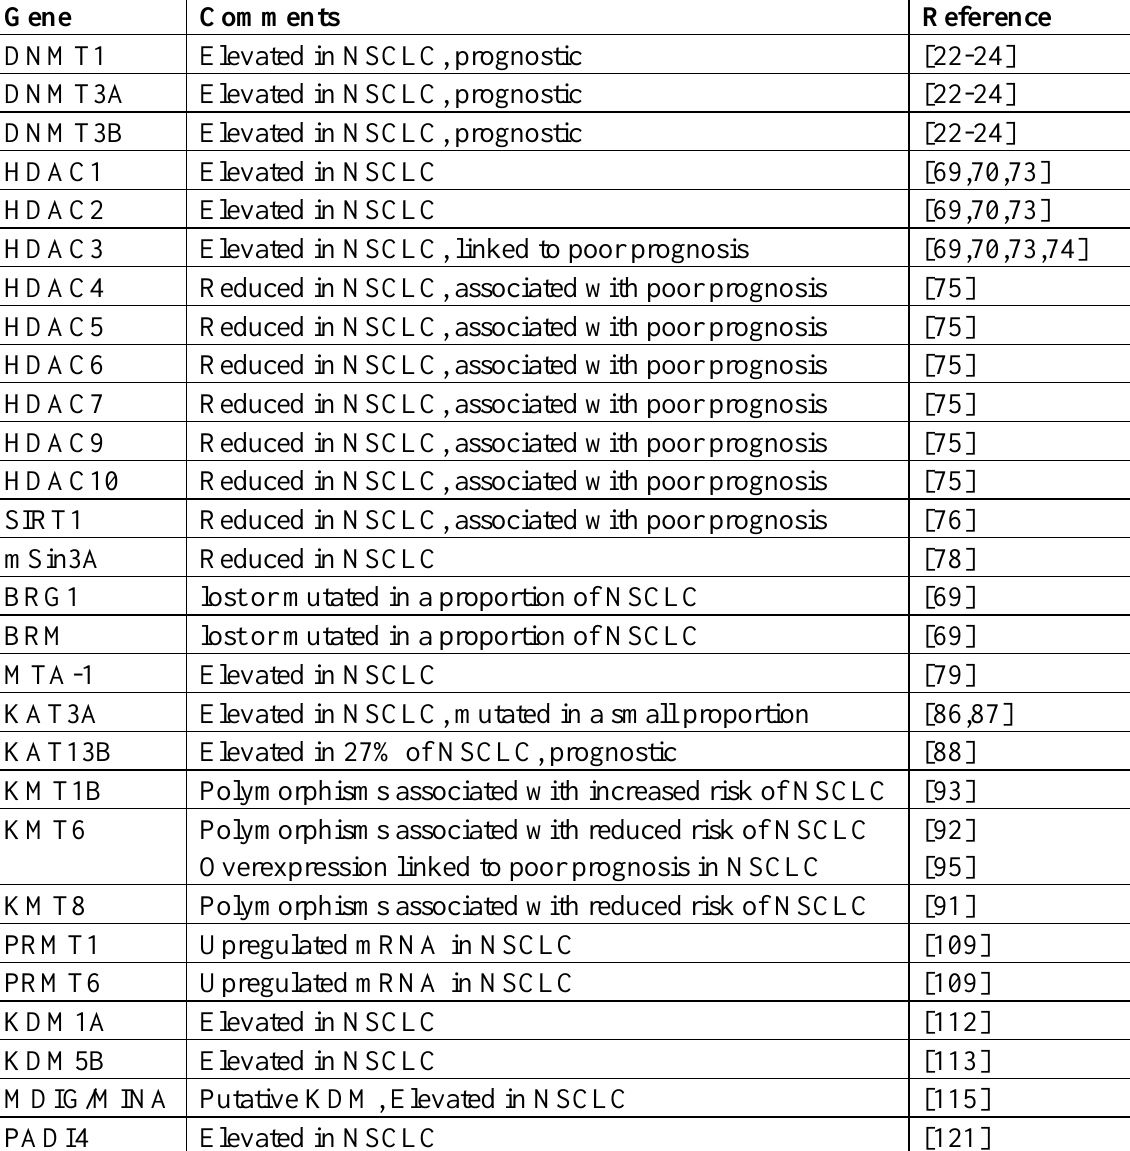
Table 2. Epigenetic modifiers with altered expression in in non-small-cell lung cancer